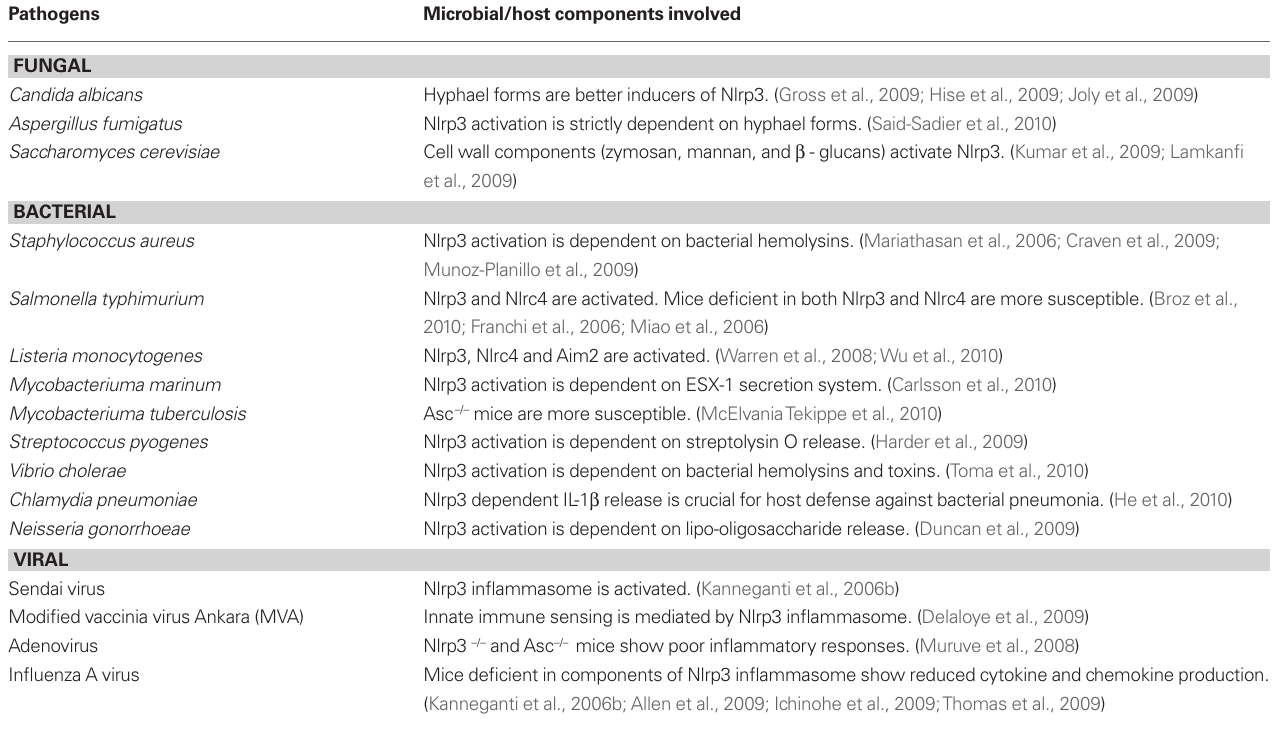
Table 1 | Microbes and microbial components that induce Nlrp3 inflammasome activation. Pathogens Microbial/host components